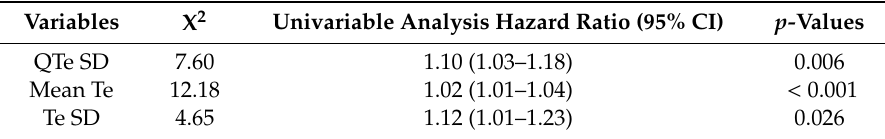
Figure 2. ( A ) QTe, QTp and Te means in the cardiovascular and non-cardiovascular deceased subjects. In the box plots, the central line represents the median distribution. Each box spans from the 25th to 75th percentile points, and error bars extend from the 10th to 90th percentile points. ( B ) QTe, QTp and Te standard deviations (SD) in the cardiovascular and non-cardiovascular deceased subjects. In the box plots, the central line represents the median distribution. Each box spans from the 25th to 75th percentile points, and error bars extend from the 10th to 90th percentile points.In the ROC analysis, the highest accuracy for 30-day mortality was found for the following variables: QTe SD (AUC: 0.705, p < 0.01), mean Te (AUC: 0.680, p < 0.01), QTeVN (AUC: 0.686, p < 0.01) and Te SD (AUC: 0.648, p < 0.05) (Figure 3A). ROC, receiver operating characteristic; AUC, area under curve; NS, not significant. QTe, QTp, Te, QTeVN (explained in the text). Table 3. Prediction of mortality in study patients by Cox regression (continuous